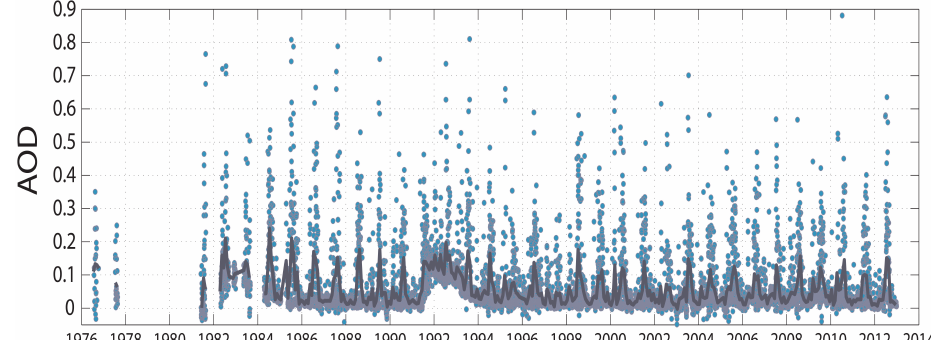
Figure 5. The long-term daily mean AOD (at 769.9nm) data series at Izaña extracted from the Mark-I scattered data (1976–1983, and 2003– Figure 5. Long-term daily mean AOD (at 769.9 nm) data series at Izaña extracted from Mark-I scattered 2012; no data available 1978–1980) and transmitted data (1984–2002). The monthly mean of the homogenized AOD series is displayed with data (from 1976 to 1983, as well as from 2003 to 2012) and transmitted data (from 1984 to 2002). the violet line for the Mark-I. Monthly mean of the homogenized AOD series is displayed with the violet line for Mark-I. No available data from 1978 to 1980.